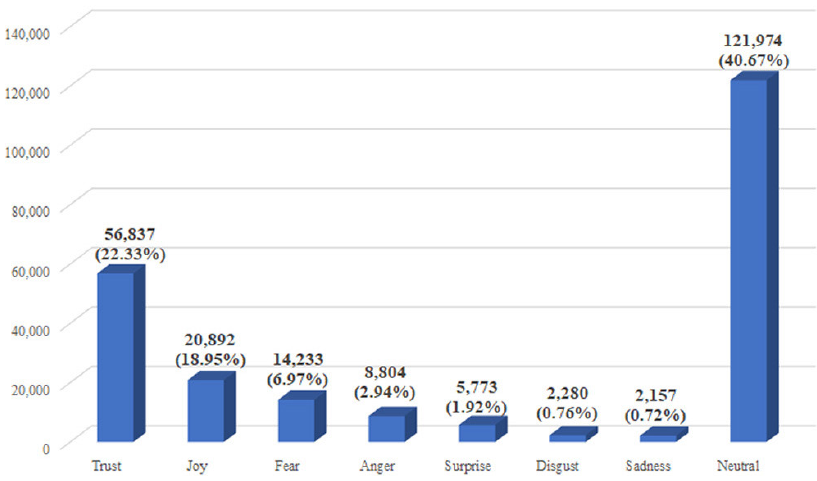
Fig. 8. Emotion frequency based on the most intense emotion of each